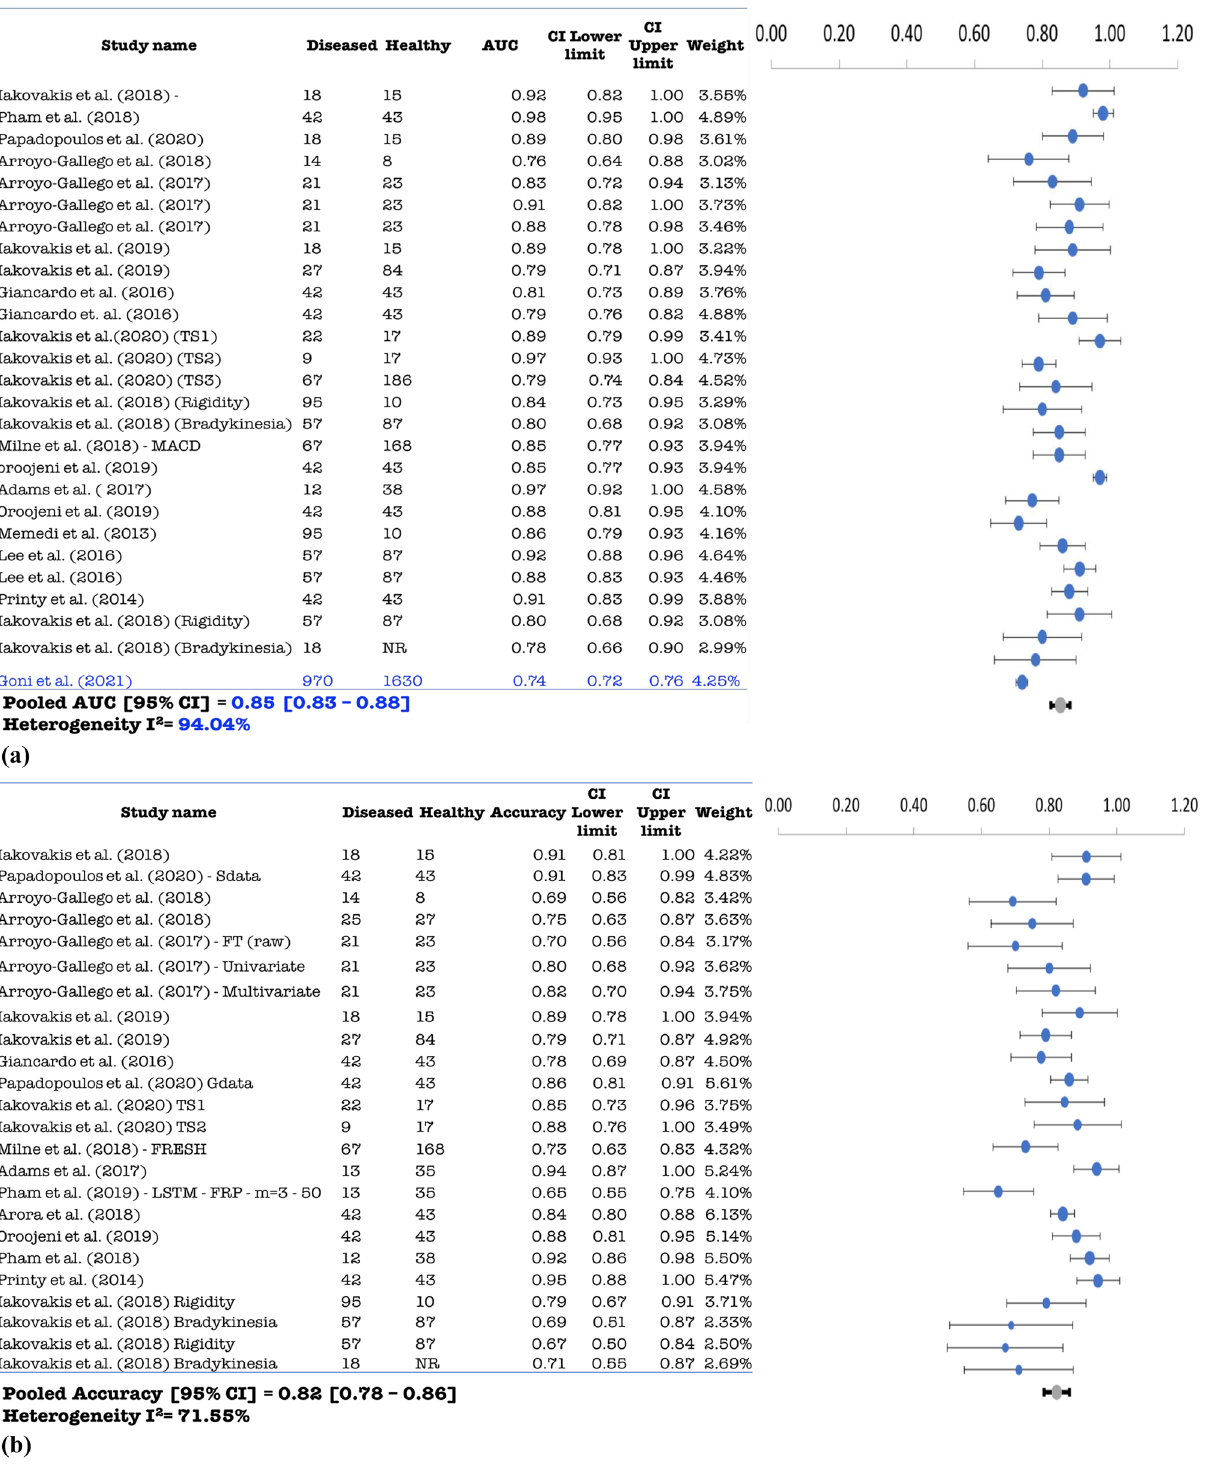
Figure 2. ( a ): Pooled AUC with 95% CI of PD studies. ( b ) Pooled accuracy with 95% CI for PD studies. ( c ) Pooled sensitivity with 95% CI for PD studies. ( d ) Pooled specificity with 95% CI for PD